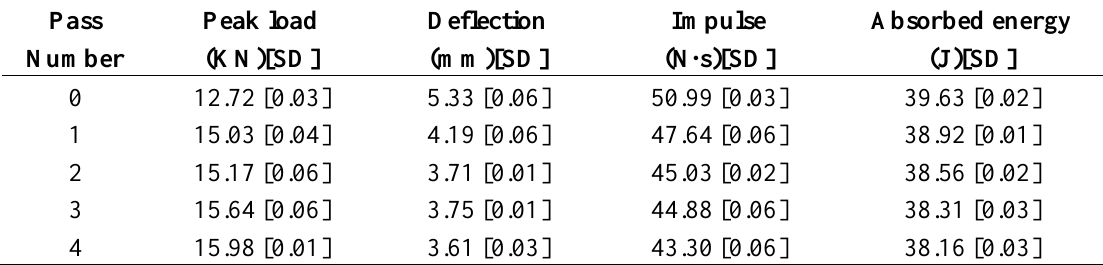
Figure 7. The ( a ) force–time and ( b ) force–deflection curves of CP aluminum billets, before and after the ECFE process, up to four passes, achieved by a drop weight impact test. Table 2. The impact characteristics of CP aluminum billets before and after the ECFE process up to the four